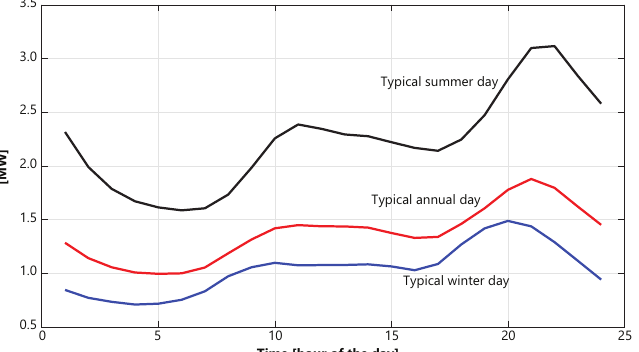
Figure 3. Daily load curves for a typical day in summer (black), winter (blue), and for the whole year (red), in absolute terms.